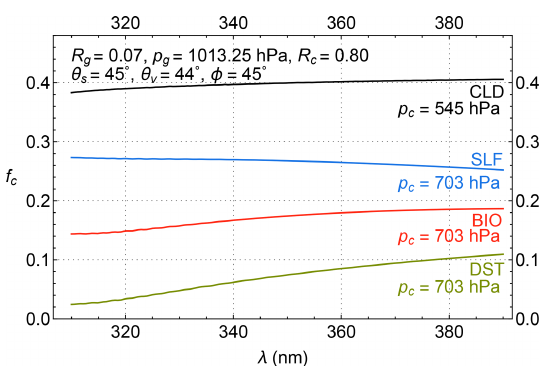
Figure 8. Four examples of cloud fractions ( f c ) derived from ex- plicitly modeled TOA radiances for particle-laden atmospheres. The first of these is the atmosphere with a 1.5km thick layer of C1 cloud (CLD; Deirmendjian, 1969) with a single-scattering albedo ω = 1 and an optical thickness τ = 5 at 340nm centered at 5km altitude (or pressure level of 545hPa). The others are atmospheres with a 1km thick layer of aerosols, including SLF ( ω = 0 . 996), BIO ( ω = 0 . 921), and DST ( ω = 0 . 900) aerosols (SLF, BIO, and DST models are taken from Torres et al., 2007), with an optical thick- ness τ = 1 . 5 at 340nm centered at 3km altitude (or pressure level of 703hPa). The insets list the MLER parameters, R g , p g , R c , and p c , as well as the angles ( θ s , θ v , and φ ) that specify the viewing illumination